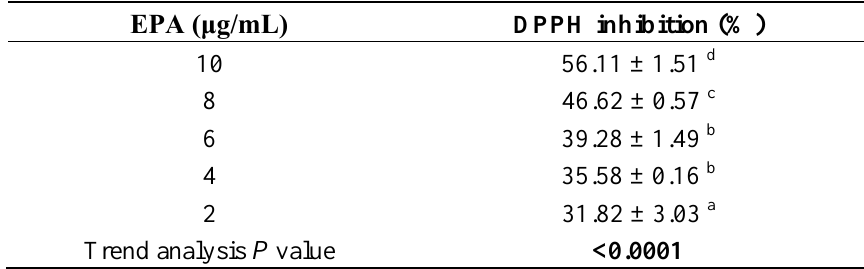
Table 2. 2,2-diphenyl-1-picrylhydrazyl (DPPH) free-radical scavenging activity of EPA.